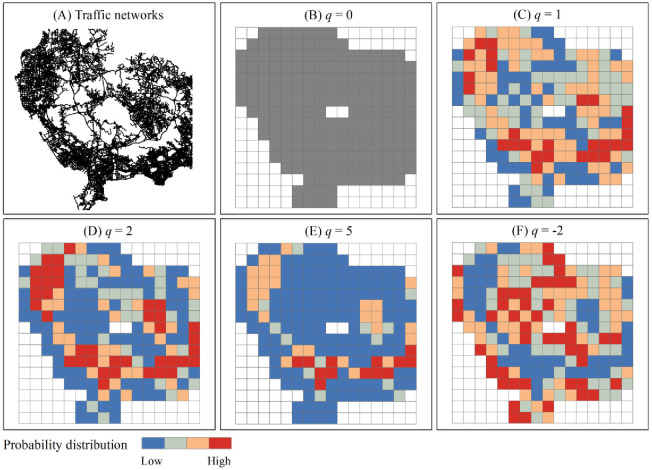
Schematic representation of rescaling probability distribution for multifractal computation based on box-counting method.The probability distribution of traffic links is calculated over all boxes and then weighted by moment order q. Dark red boxes represent dominant structures with higher weighted probability, and dark blue boxes represent lightweight regions with lower weighted probability. (A) Partial traffic networks in Shenzhen. (B) When q = 0, all nonempty boxes are equally weighted (gray). (C) When q = 1, the nonempty boxes are weighted by real growth probability. (D)-(E) For q>0, the boxes with relative high-density measures gradually gain more importance and their contribution to the entropy will dominate. (F) For q<0, the boxes with relatively low-density measures gradually gain more importance and their contribution to the entropy will dominate.